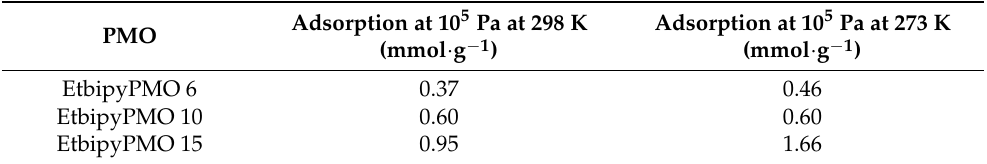
Table 6. CO 2 sorption capacity of the BTEE/Etbipyridine PMO NPs.